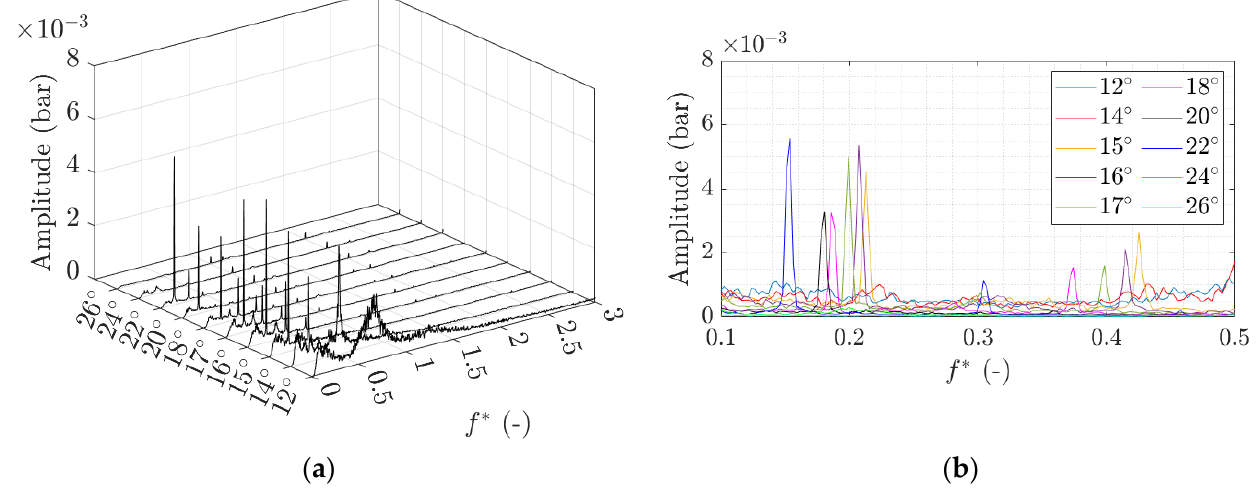
Figure 6. Spectra of the PM pressure signals calculated with Equation (5) using P1x 0° and P1x 180° at α from 12° to 26° ( a ) and zoomed in around PM peak ( b ).